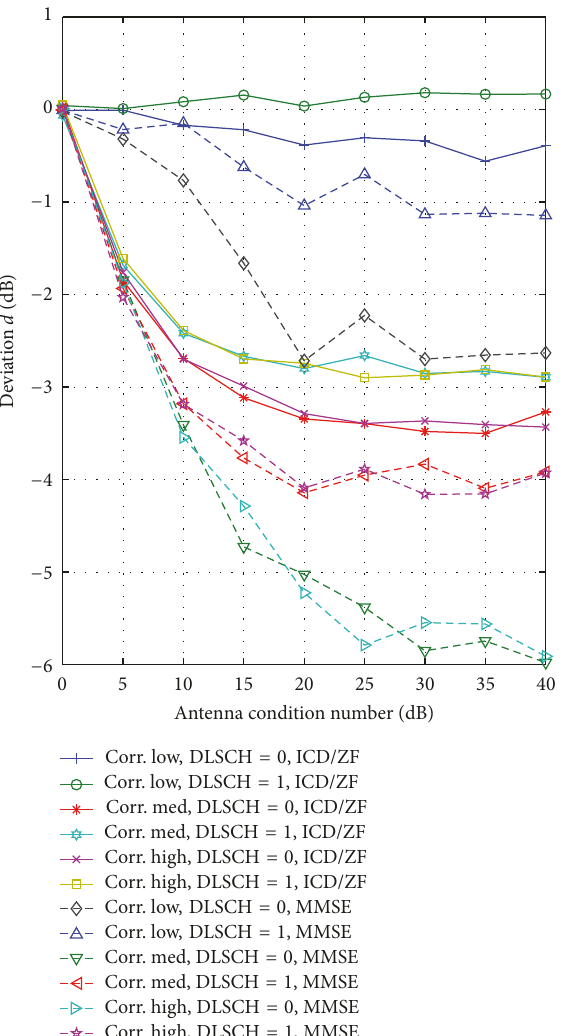
Figure 15: Deviation 𝑑 versus antenna condition number for DLSCH processing off, nonideal/ideal channel estimation; low,